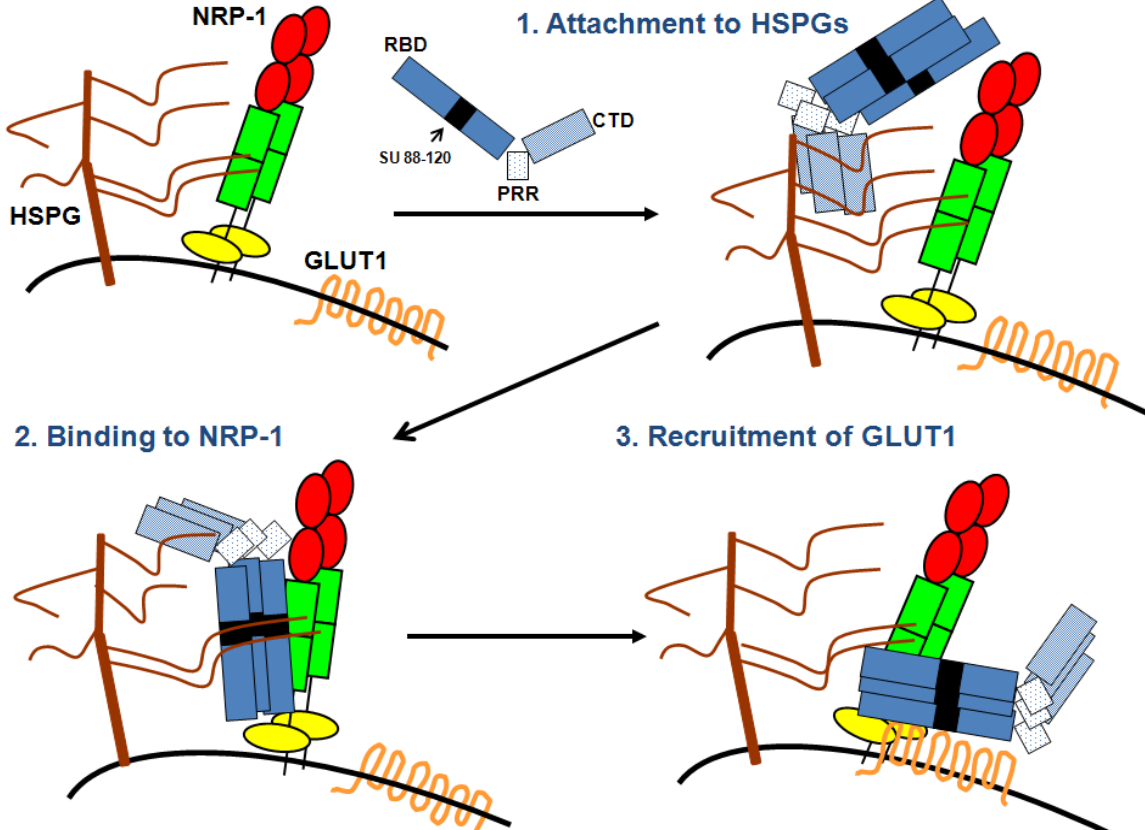
Figure 2. A multireceptor model for HTLV-1 entry. HSPGs, NRP-1 and